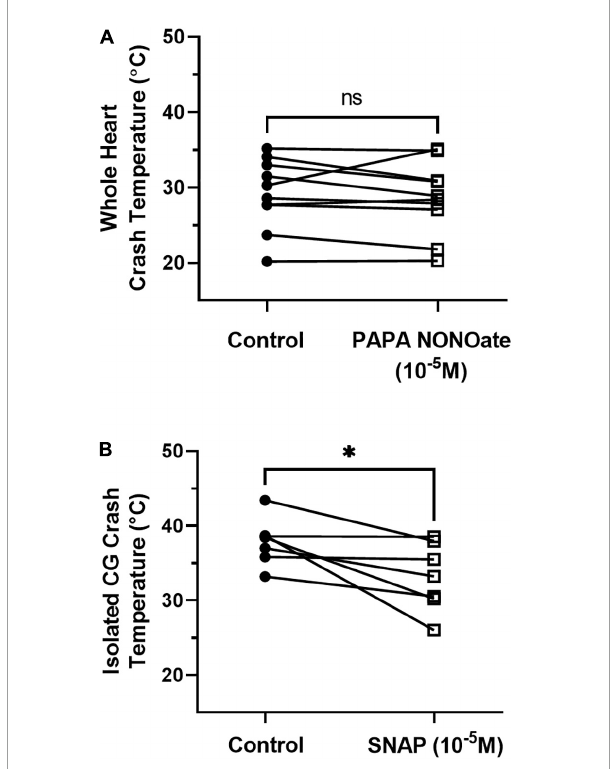
FIGURE8 NO donors differently affect the crash temperature of whole heart and ICG preparations. (A) Plot of crash temperature for whole hearts perfused with normal saline compared to the same hearts perfused with saline and the NO donor PAPA NONOate (10 – 5 M). PAPA NONOate did not alter crash temperature; paired t -test: p = 0.4, N = 10; Shapiro–Wilks test: saline: p = 0.69, N = 10; NONOate: p = 0.47, N = 10. (B) Comparison of crash temperature between isolated cardiac ganglia superfused with normal saline and ganglia superfused with saline and the NO donor SNAP (10 – 5 M) within the same set of preparations. Preparations exposed to SNAP crashed at a lower temperature than controls; paired t- test, p = 0.032, N = 7; Shapiro–Wilks test: saline: p = 0.49, N = 7; SNAP: p = 0.53, N = 7. *Indicates p < 0.05, ns indicates not